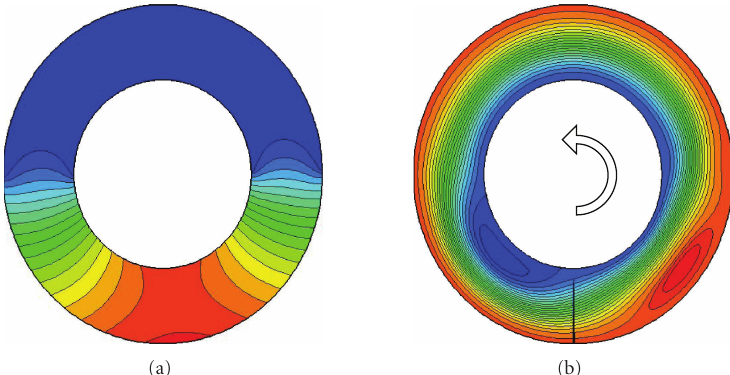
Figure 3: Temperature and stream function fields in a pseudoconductive regime; Ra = 10, R = 1 . 8, and Pr = 5. (a) Isotherms, from 0.5 (blue) to 8.5 (red) in steps of 0.5. (b) Stream function field, from − 0.005 (blue) to 0.1 (red) in steps of 0.005 (Vortex in the red zone: 0.102, 0.104).